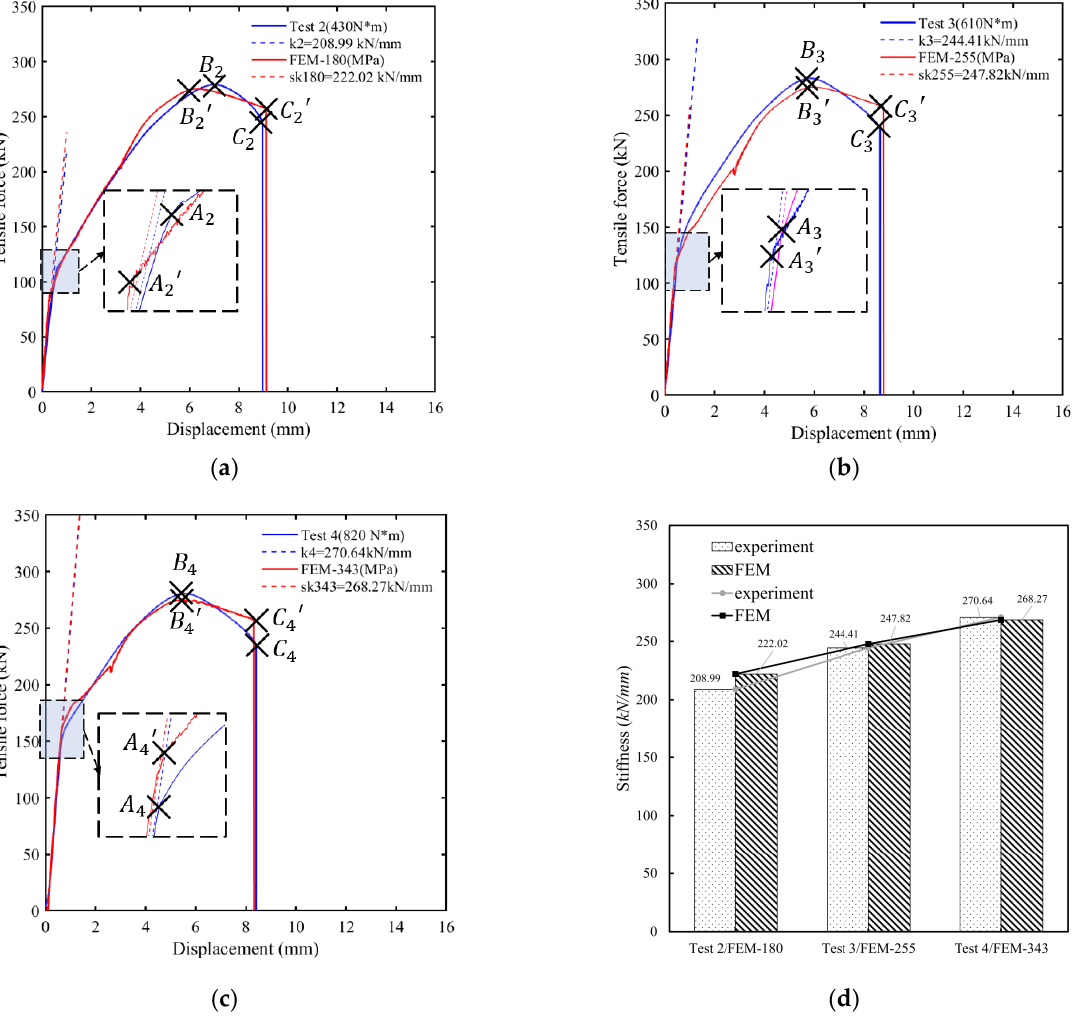
Figure 25. Comparison of loading curves between Tests 2 to 4 and the numerical simulation: ( a ) Loading curves of Test 2 and Sim-180, ( b ) Loading curves of Test 3 and Sim-255, ( c ) Loading curves of Test 2 and Sim-343, ( d ) Stiffness of the initial elastic phase of the experimental and simulated curves. Table 8. Relative errors (%) of loading curve characteristics between Test 2 to 4 and the simulation.